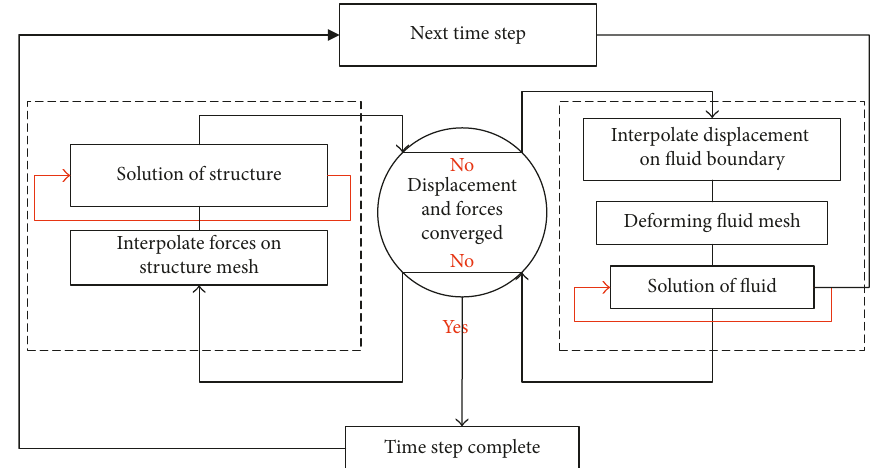
Figure 2: Two-way coupling